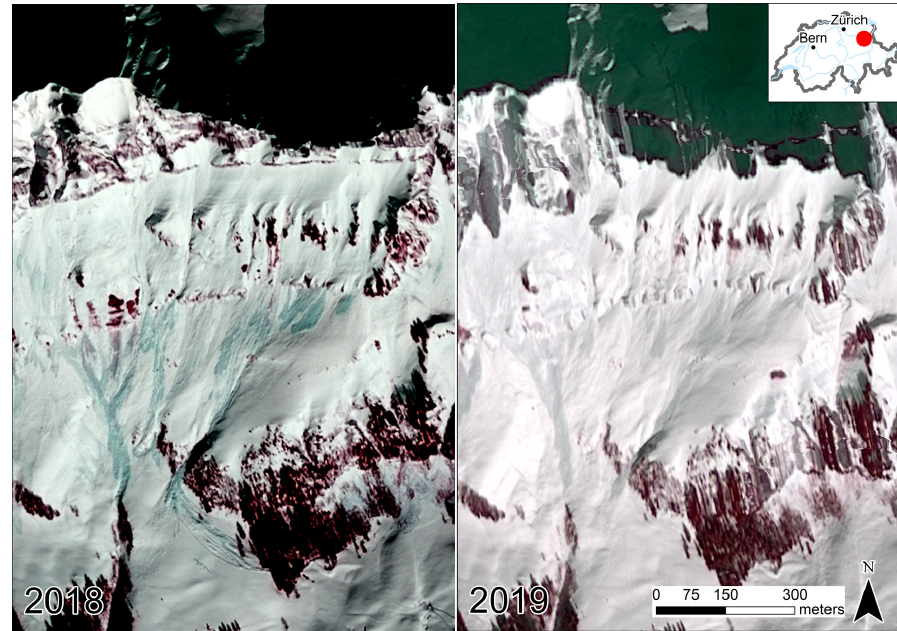
Figure 11. In 2018, the temperatures and the snowfall line were high resulting in more wet-snow avalanches and deposits. Those are identifiable by the green shimmer in the NIR and more contrast to the surrounding snow in general (left side), which is not the case for the mostly dry-snow avalanches in 2019 (right side). Additionally, disparity in visibility in steep terrain due to different inclination angles is shown. The inclination angle for the tiles shown here lies at 11.3 ◦ in 2018 and at 27.6 ◦ in 2019. These distortions are among the worst we encountered comparing 2018 and 2019 SPOT data (SPOT 6 data © Airbus DS